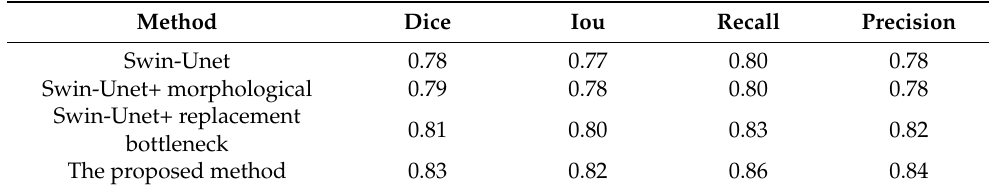
Table 5. The impact of different degrees of improvement on model segmentation ability on datasets with multi-scale and multi-region edema.